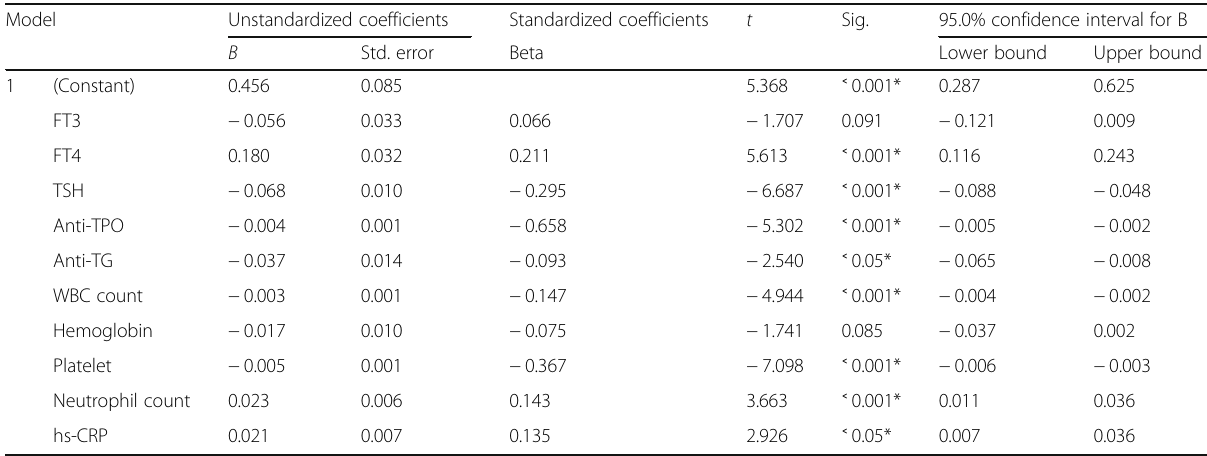
Table 3 Logistic regression analysis to determine the variable associated with DMDs in MS patients with thyroiditis